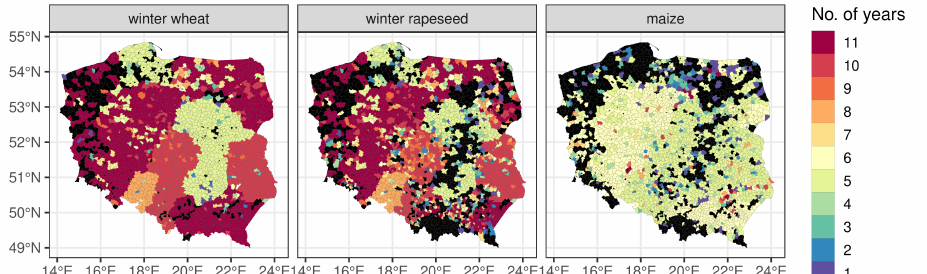
Figure 3. Time span of official crop yield statistics at the LAU level. Black signifies no data.